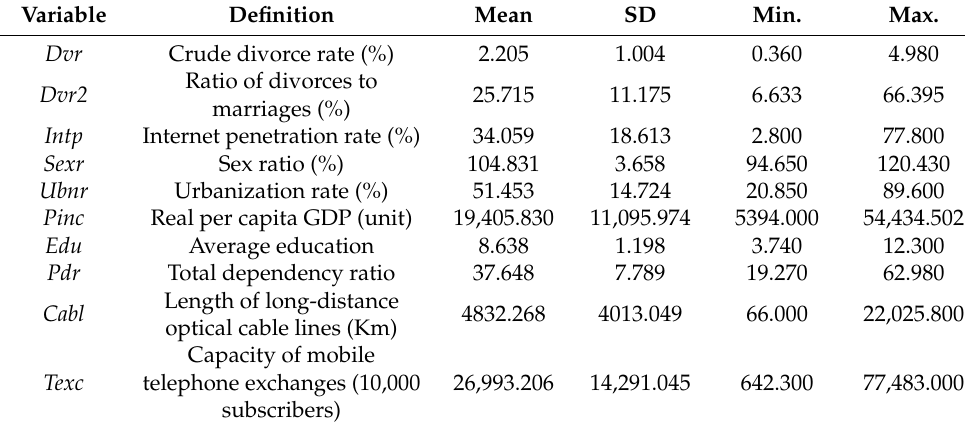
Table 2. Summary statistics of key variables for provincial data ( N =